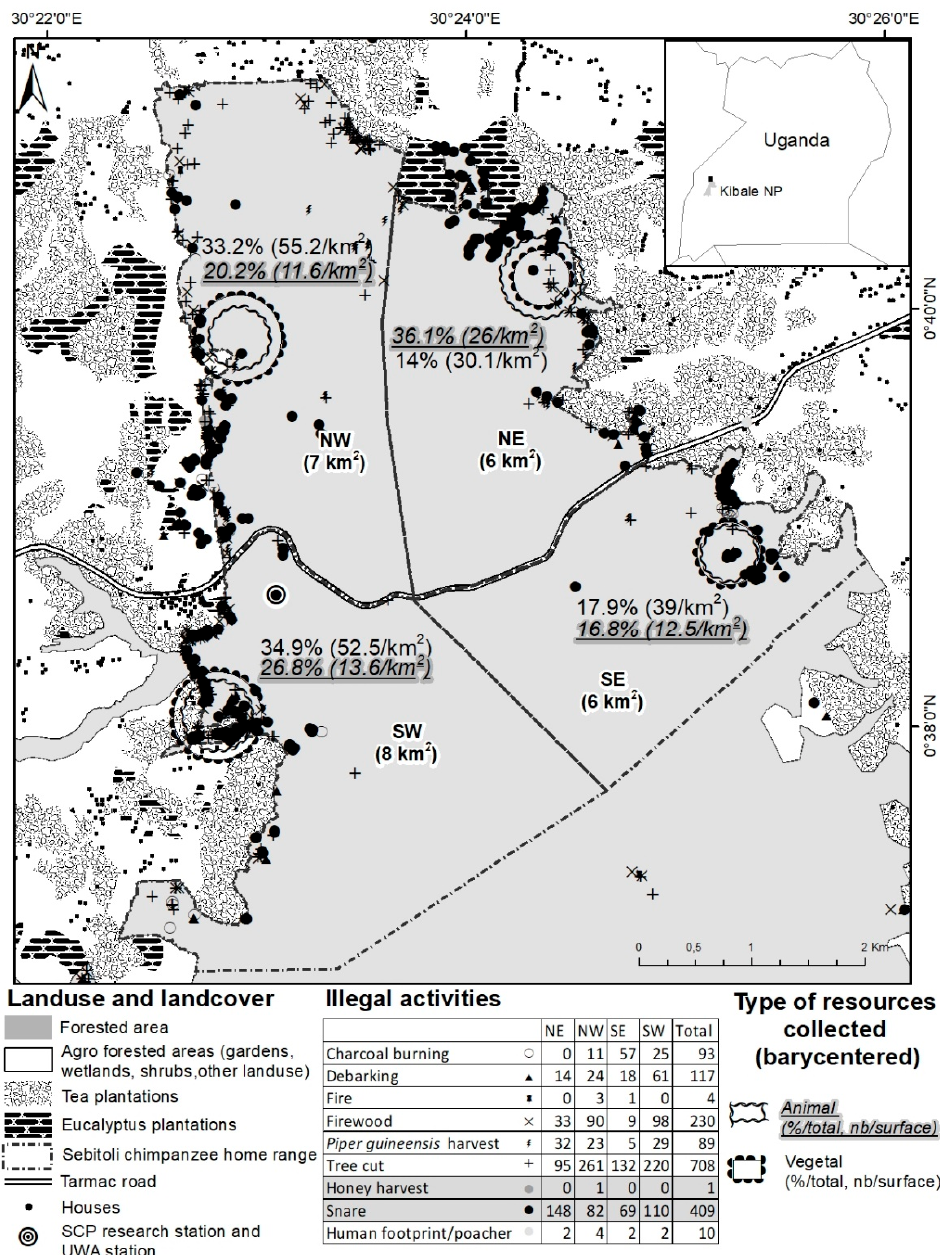
Figure 2. Illegal activities identified by SCP snare removal team (29 May 2015–30 November 2016), Sebitoli area, Kibale National Park, Uganda.